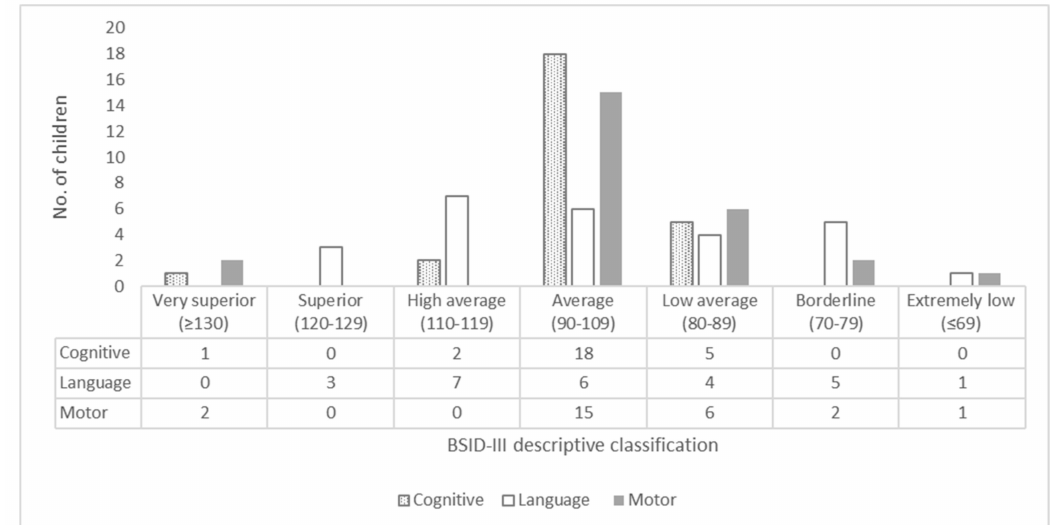
Figure 1. Qualitative description of the composite scores of the cognitive, language and motor domains for 26 non-microcephalic children exposed to the Zika virus in the intrauterine period, Manaus, Amazonas,